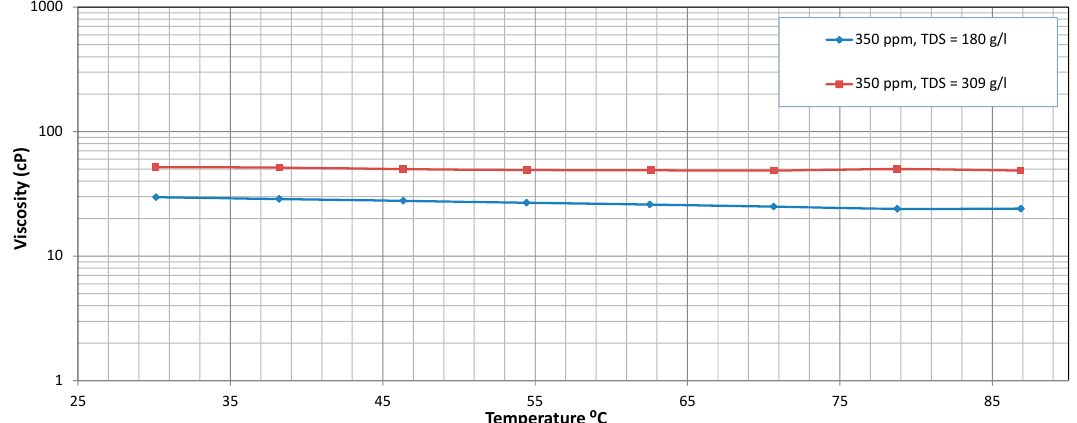
Figure 6. Temperature sweep for the biopolymer solutions using 180 g/L and 309 g/L brine. TDS: total dissolved solids.